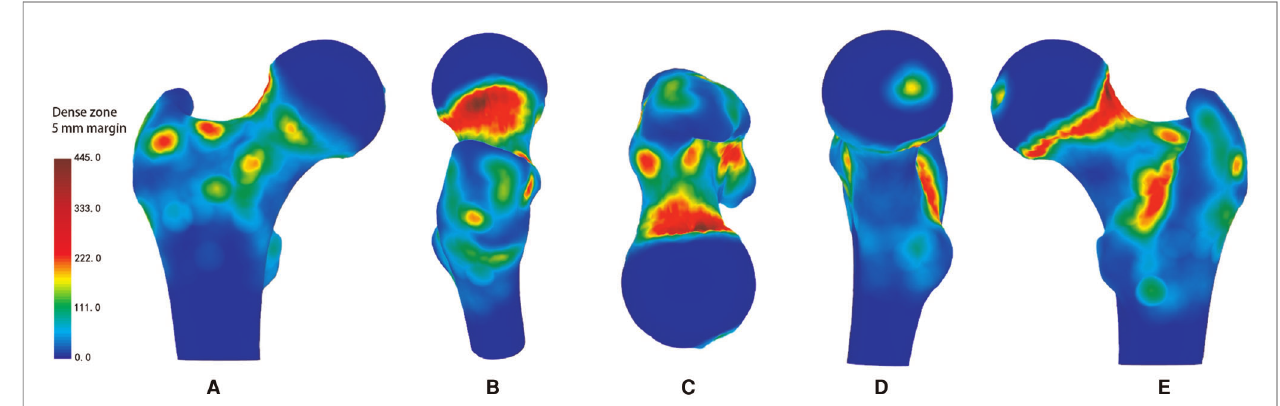
FIGURE 3 | Representative views of the 3-D heat mapping with a 5-mm margin of 100 specimens of all nutrient foramina in the proximal femur, including anterior, lateral, superior, medial and posterior views. Red colour regions, de fi ned as dense zones, represent higher frequency of nutrient foramina, while yellow and green colour regions, de fi ned as lower dense zones, represent lower frequency of